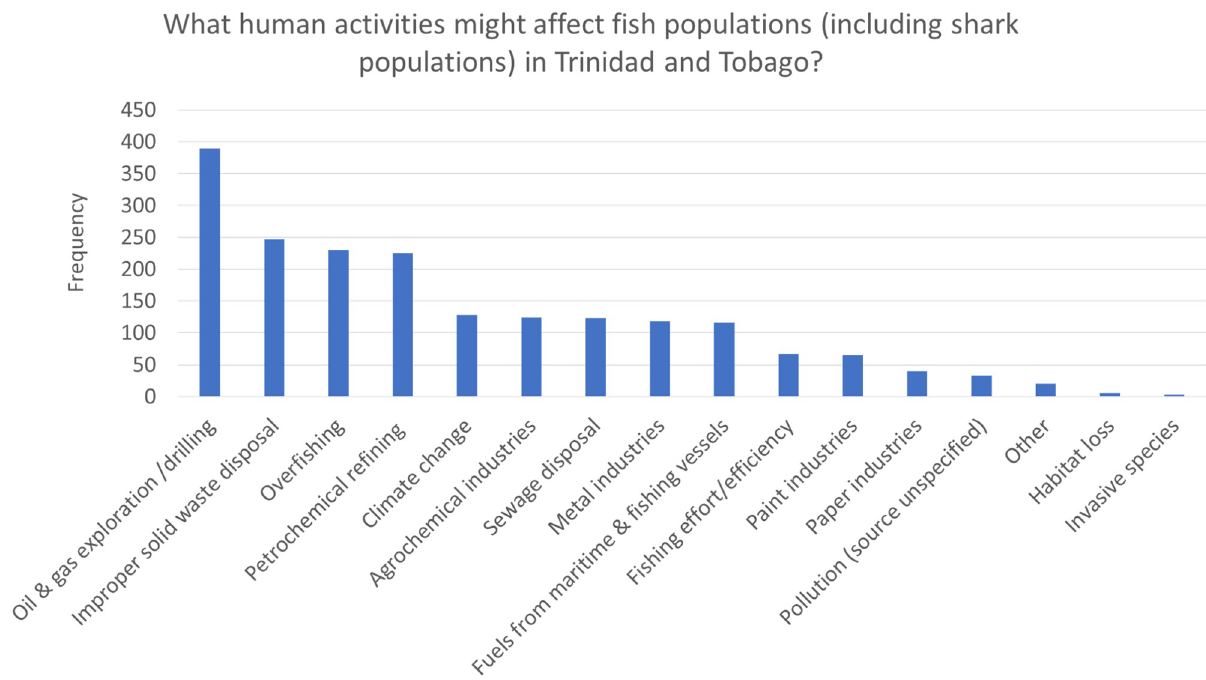
Fig 1. Frequency and percentage of respondents who correctly identified anthropogenic factors which might affect fish/shark populations in Trinidad and Tobago. (See S3 Appendix for Table).